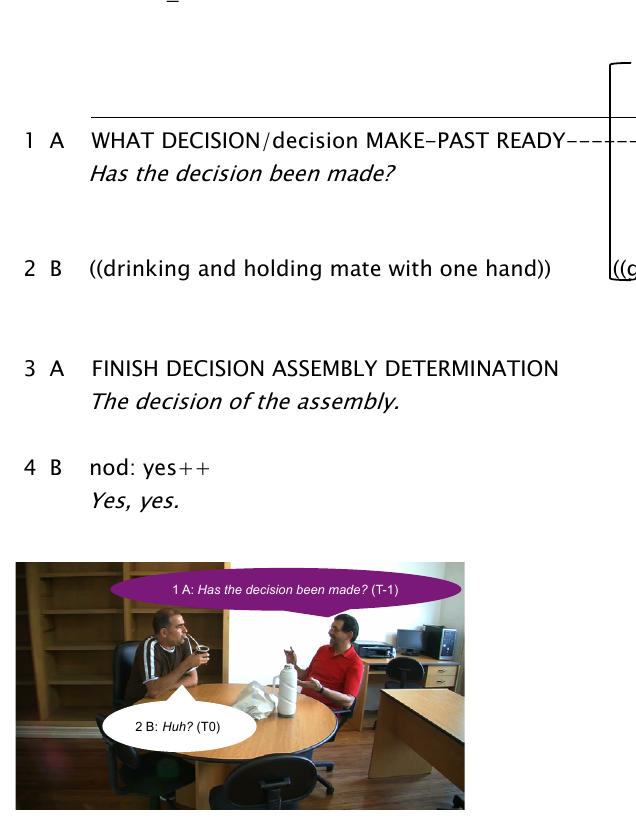
Figure 8. ‘Huh?’ , Person B, on the left, initiates repair on Person A’s previous turn by pushing his lips forward, line 2 (T0). The mouth action of puffing out one’s cheeks combined with eyebrows together is another common format to indicate understanding problems in LSA. This mouth gesture has been described and analyzed 3 Mate is an Argentinian drink, similar to green